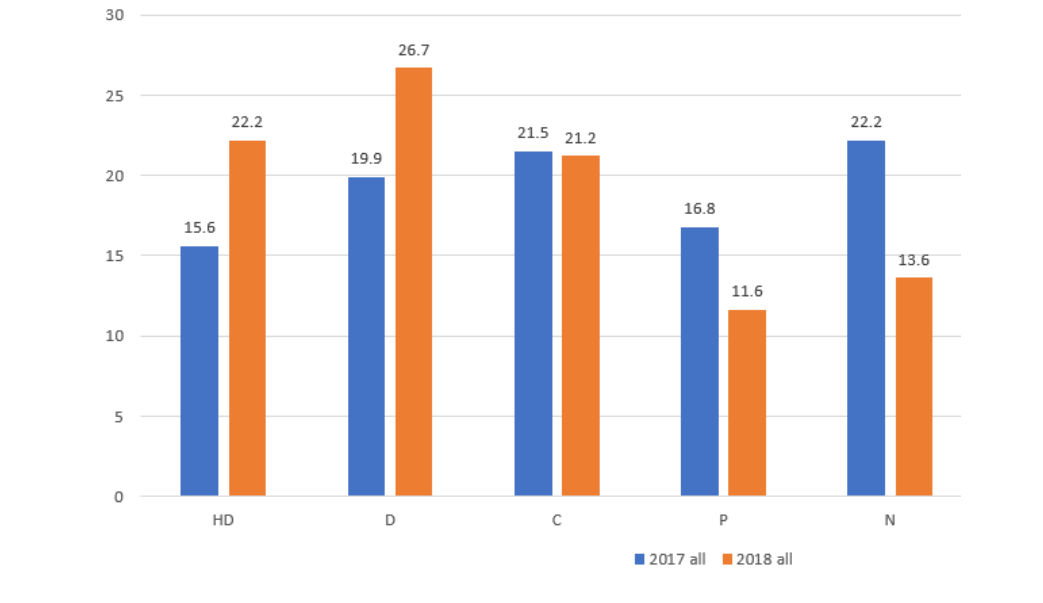
Figure 4. Average grade distribution in the block showing an increase in proportion of students achieving higher assessment